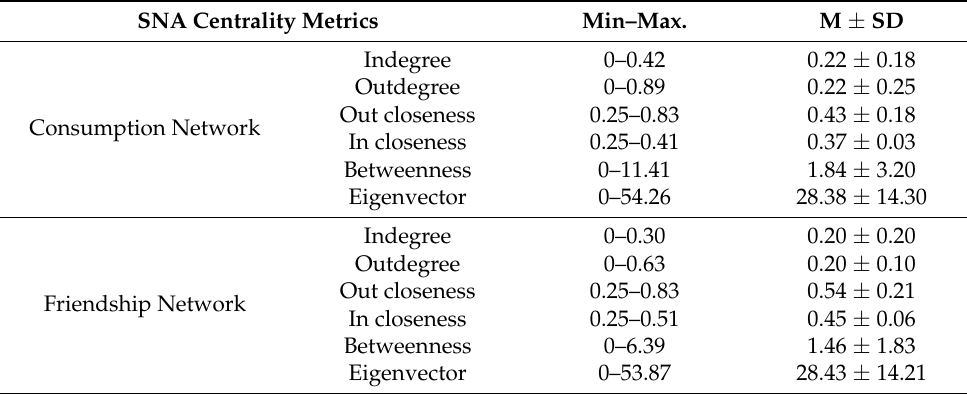
Table 3. Descriptive indicators of centrality in consumption and friendship networks.